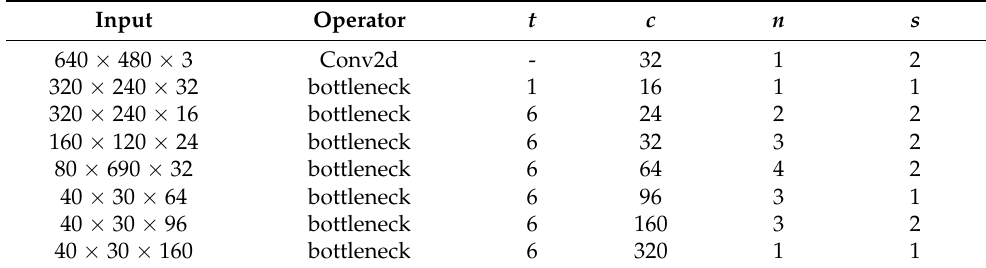
Table 2. Backbone network